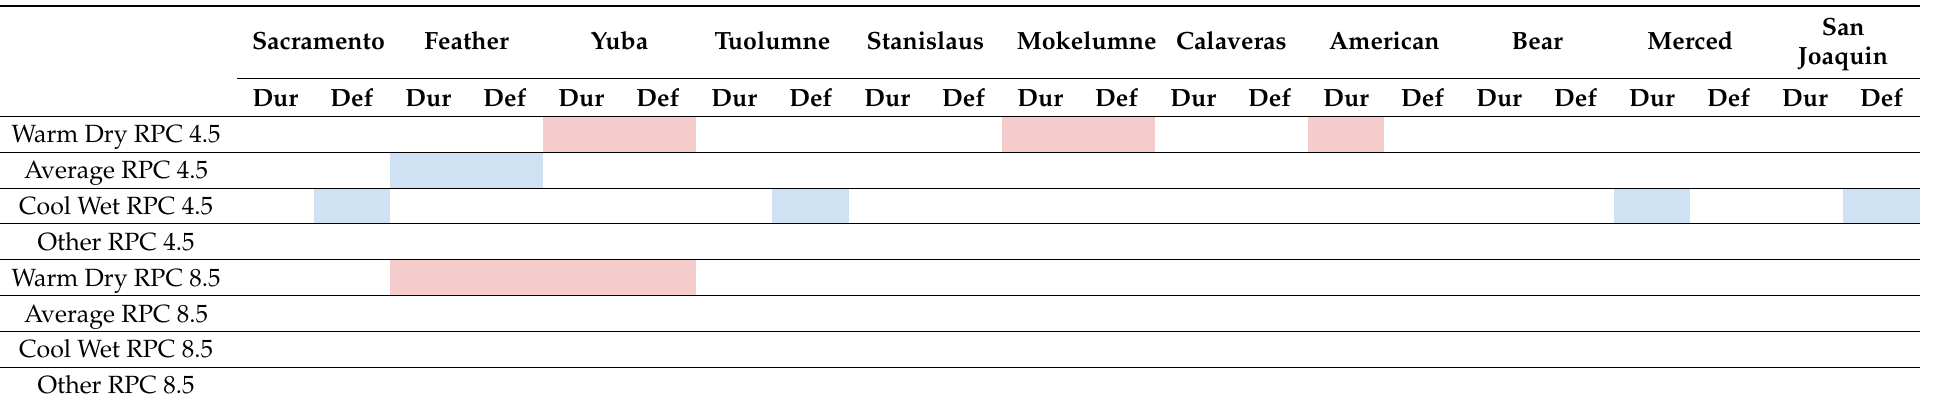
Table 2. Individual streamflow station two tailed difference in means t -tests for drought duration (Dur) and deficit (Def). Highlighted boxes indicate a significant difference (at a 0.05 level) between historical and model projected means. Red represents a higher projected mean than historical. Blue represents a lower projected mean than